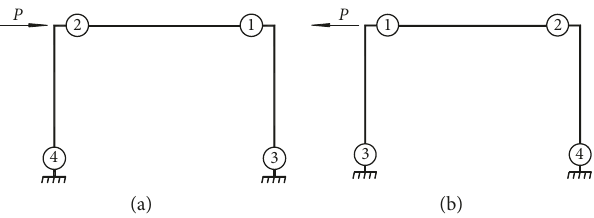
Figure 4: The order of KJ-1 plastic hinge formation: (a) right horizontal load, (b) left horizontal load.